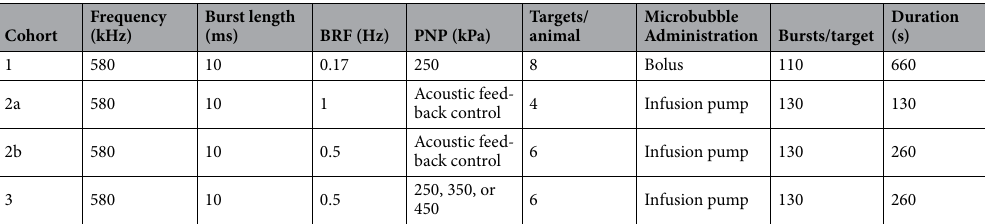
Table 2. FUS + MB exposure parameters for each cohort of animals. BRF burst repetition frequency.